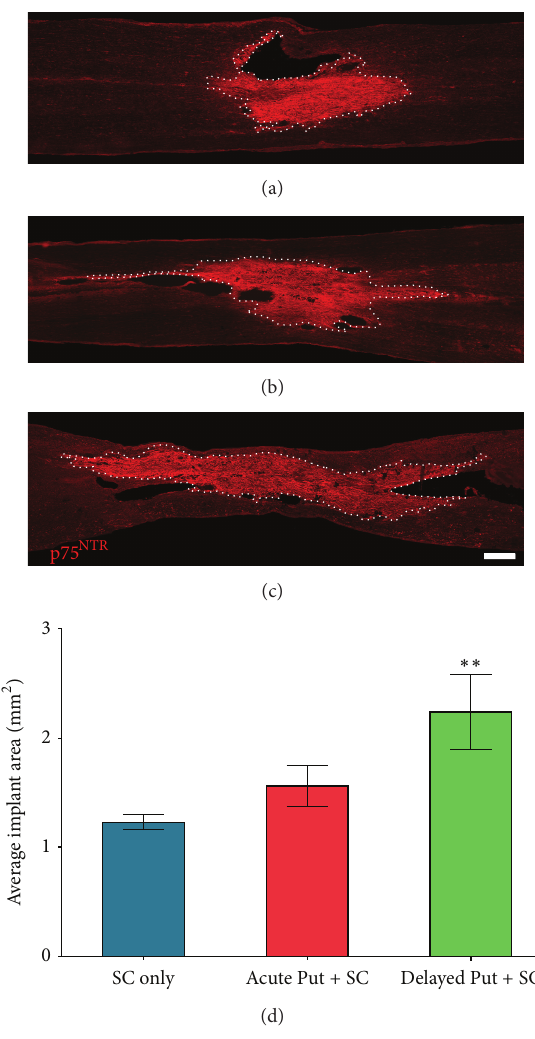
Figure 3: Delayed putrescine supplementation significantly increases SC implant size. To determine the effect of putrescine on the size of the implant, immunostaining for p7 5 NTR was performed and the area of immunoreactivity quantified. Images from representative animals show the extent of p7 5 NTR immunoreactivity among the different SC implant groups: (a) vehicle control, (b) immediate putrescine, and (c) delayed putrescine. Scale bar = 500 𝜇 m. Dotted white lines indicate the extent of the SC implant. Stereological quantification of the implant area shows an increase in size when putrescine is administered in a delayed fashion, but not acutely, as compared to the SC with vehicle control (d). Statistical significance indicated at ∗∗ 𝑝 < 0.01 compared to SCs with vehicle control